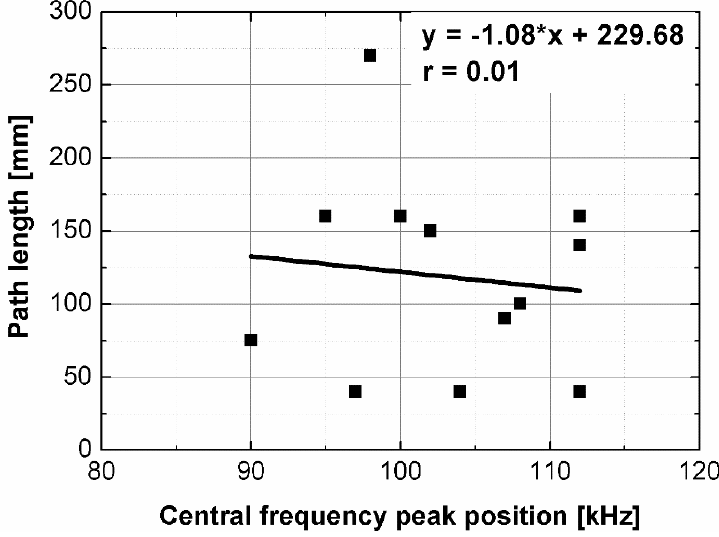
Figure 11. Path length plotted against position of central frequency peak.